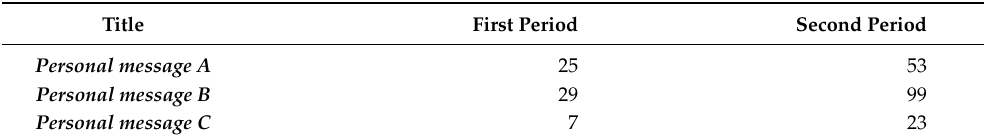
Table 6. Contingency table from Title in user H . This feature is considered as time-invariant because p -value > 0.05.